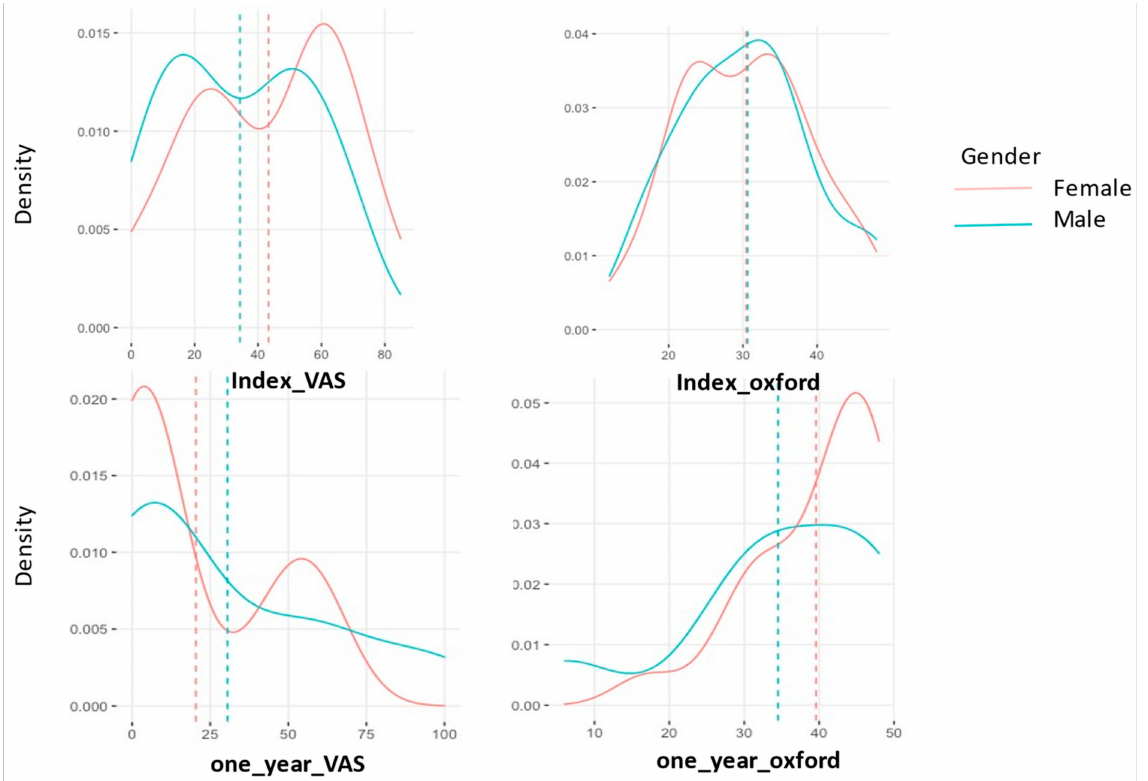
Figure 4. Index (pre-operative) and 1 year (post-operative) VAS and OHS density distribution in patients who received MFAT only. The x -axis shows VAS (0–100) and OHS (0–48) pre and 1 years post MFAT injection. The y -axis shows the density distribution of the variables.